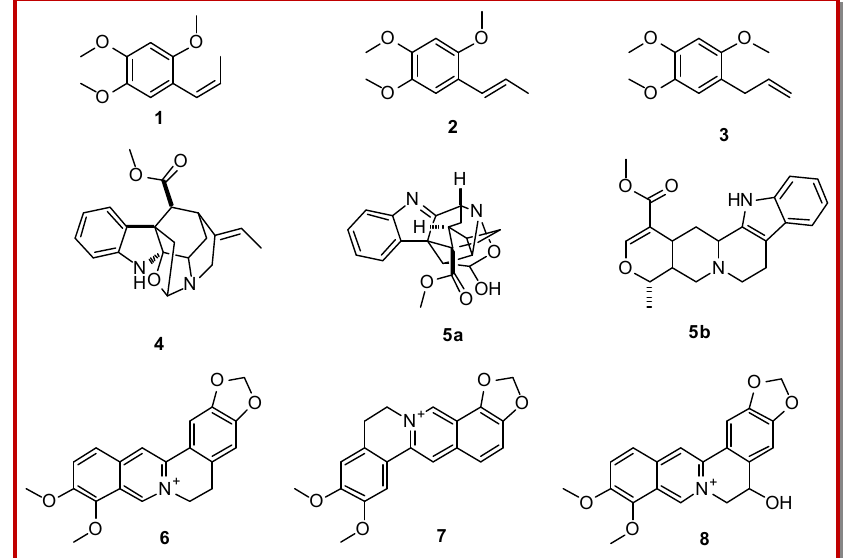
Figure 2: The structures of the compounds present in the active extracts as indicated by LC-MS